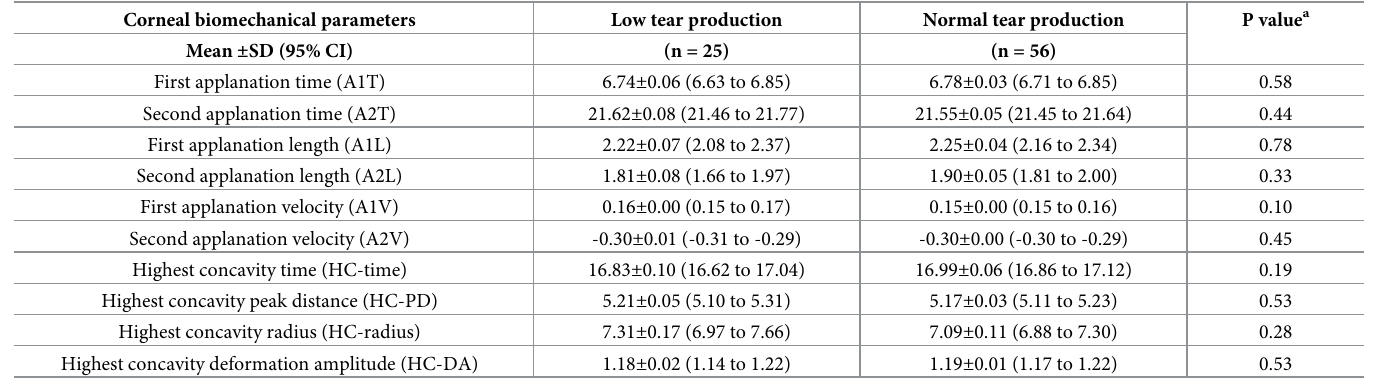
Table 3. Corneal biomechanical parameters of the low and normal tear production groups. Corneal biomechanical parameters